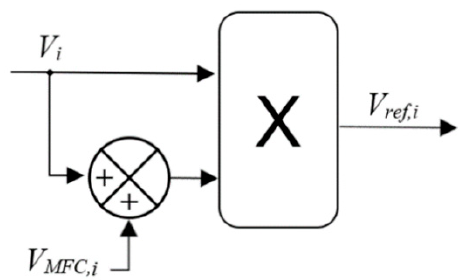
Figure 6. Addition of the model-free control (MFC) output signal to a power electronic (PE)-based DER to change the inverter’s voltage reference.